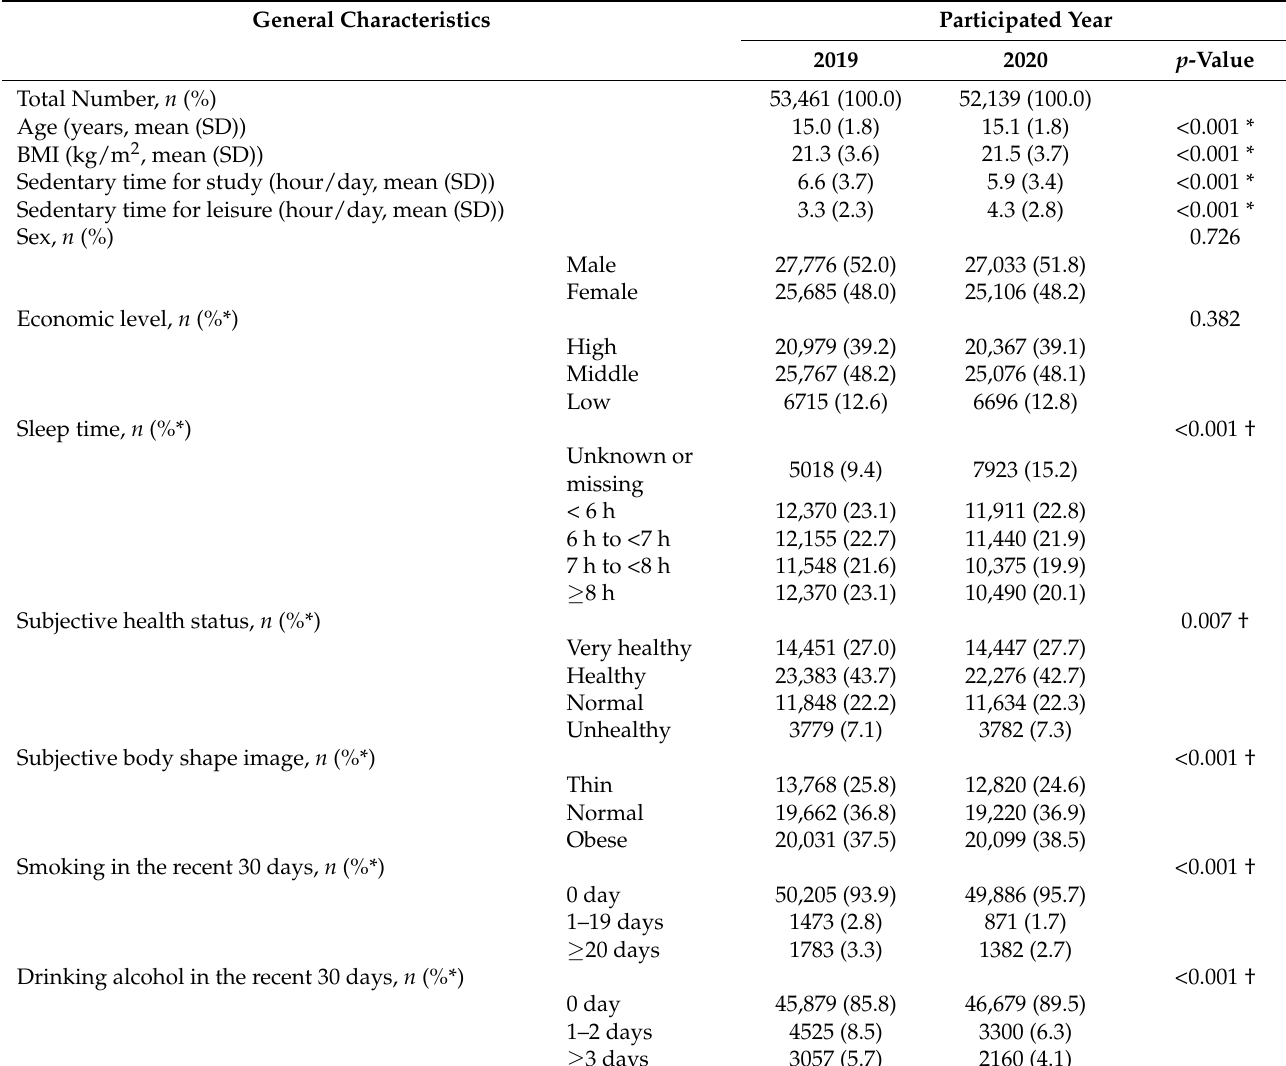
Table 1. General Characteristics of